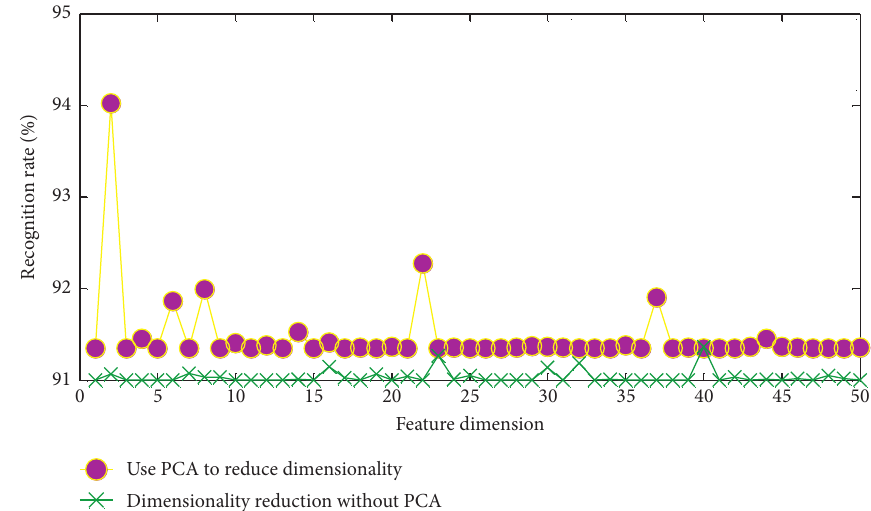
Figure 7: Image recognition result after dimensionality reduction based on